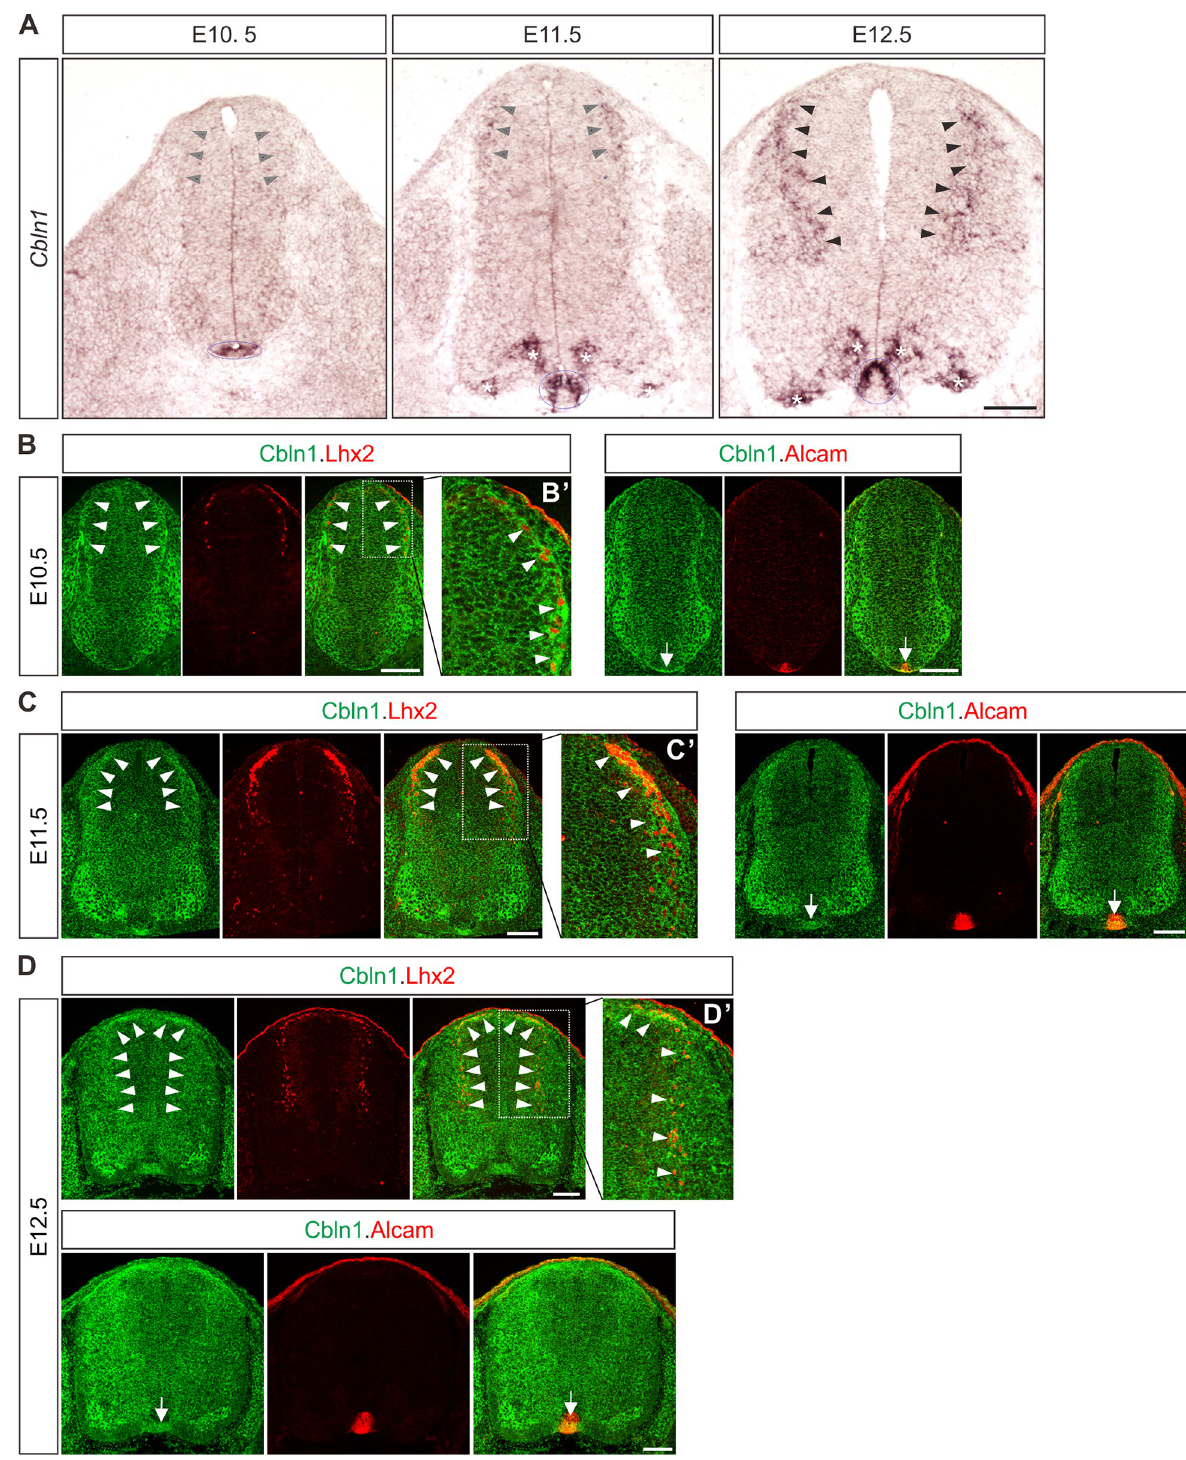
Fig 1. Expression patterns of Cbln1 and Cbln1 in the developing mouse spinal cord. ( A ) In situ hybridization was carried out using a DIG- labelled RNA probe against Cbln1 in spinal cord cross-sections during E10.5~E12.5. Arrowheads, circled areas, and asterisks indicate the expression of Cbln1 in the DCNs, the FP, and motor neurons, respectively. Scale bar, 100 μ m. ( B – D ) Co-immunostaining of Cbln1 with Lhx2 or Alcam in spinal cord cross-sections during E10.5 (B), E11.5 (C), and E12.5 (D) showed expression of Cbln1 in the DCN neurons (white arrowheads) and FP (arrows). Higher magnification insets were shown to highlight the expression of Cbln1 in Lhx2 + dI1 neurons (B’–D’). Scale bars, 100 μ m. Cbln1, cerebellin 1; DIG, digoxigenin; DCNs, dorsal commissural neurons; dI1, dorsal interneuron 1. https://doi.org/10.1371/journal.pbio.3001853.g001 PLOS Biology | https://doi.org/10.1371/journal.pbio.3001853 November 17,